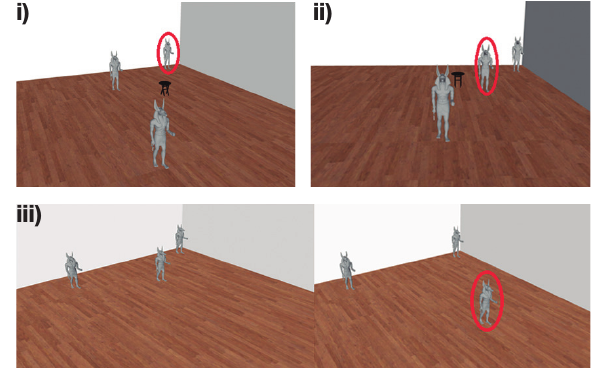
Figure 2. Screenshots from wall, stool and memory subtasks of the Statue test. Participants view images and are asked i) identify the statue closest to the wall (permanent landmark), ii) identify the statue closest to the stool (transient landmark), iii) identify which statue moved its loca- tion. Note, red circled figures are only shown for illustration purposes to identify the correct choice for each example, which was not shown to the